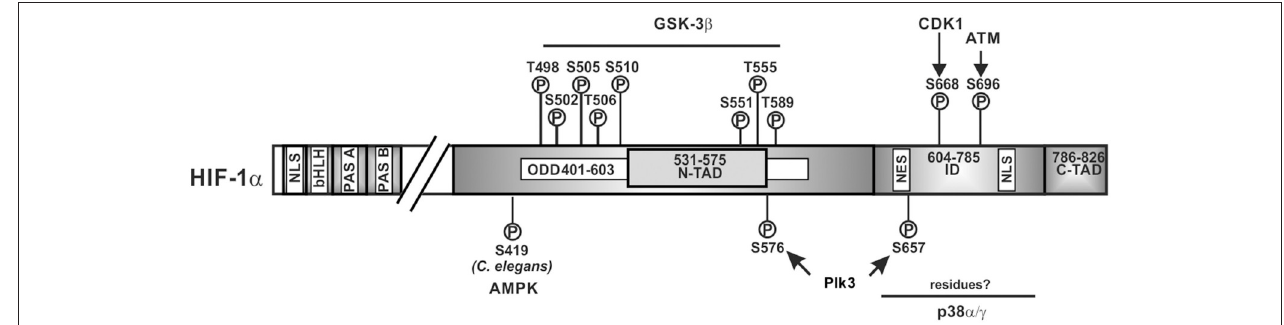
FIGURE 2 | Kinases and amino acid residues in HIF-1 α involved in regulation of HIF-1 α stability. Scheme of HIF-1 α and its domain organization with specific amino acid residues which can be phosphorylated; all have been shown to contribute to the regulation of HIF-1 α protein stability. HIF-1 α is phosphorylated on specific residues (T498, S502, S505, T506, and S510 or S551, T555, and S589) by GSK3 β ; Plk3 can phosphorylate S576 and S657; ATM can phosphorylate S696 and CDK1 can phosphorylate S668. ATM, ataxia and teleangiectasia mutated; CDK1, cyclin-dependent kinase-1; GSK3 β , glycogen synthase kinase-3b; Plk3, polo-like kinase 3; bHLH, basic helix loop helix domain; NLS, nuclear localization sequence; PAS, Per-ARNT-Sim domain; N-TAD, N-terminal transactivation domain; ID, inhibitory domain; C-TAD, C-terminal transactivation domain; numbers indicate the amino acid residue range of the respective